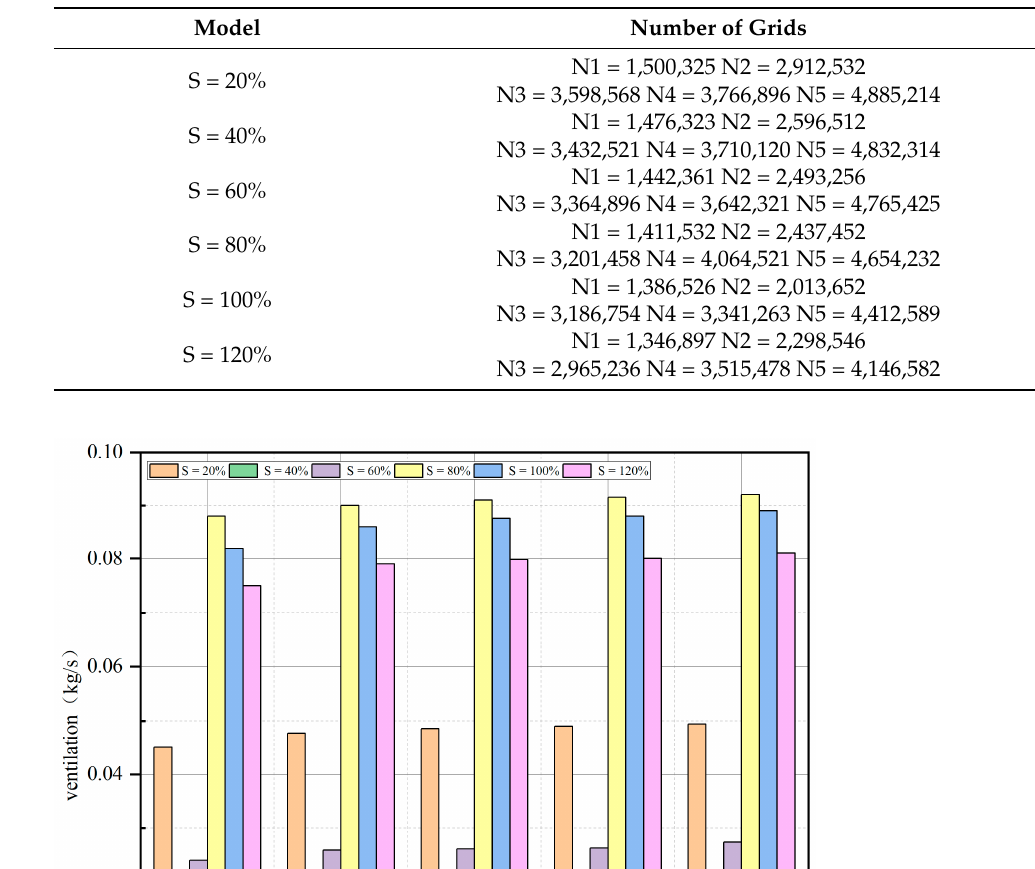
Table 1. The number of grids verified under different models.